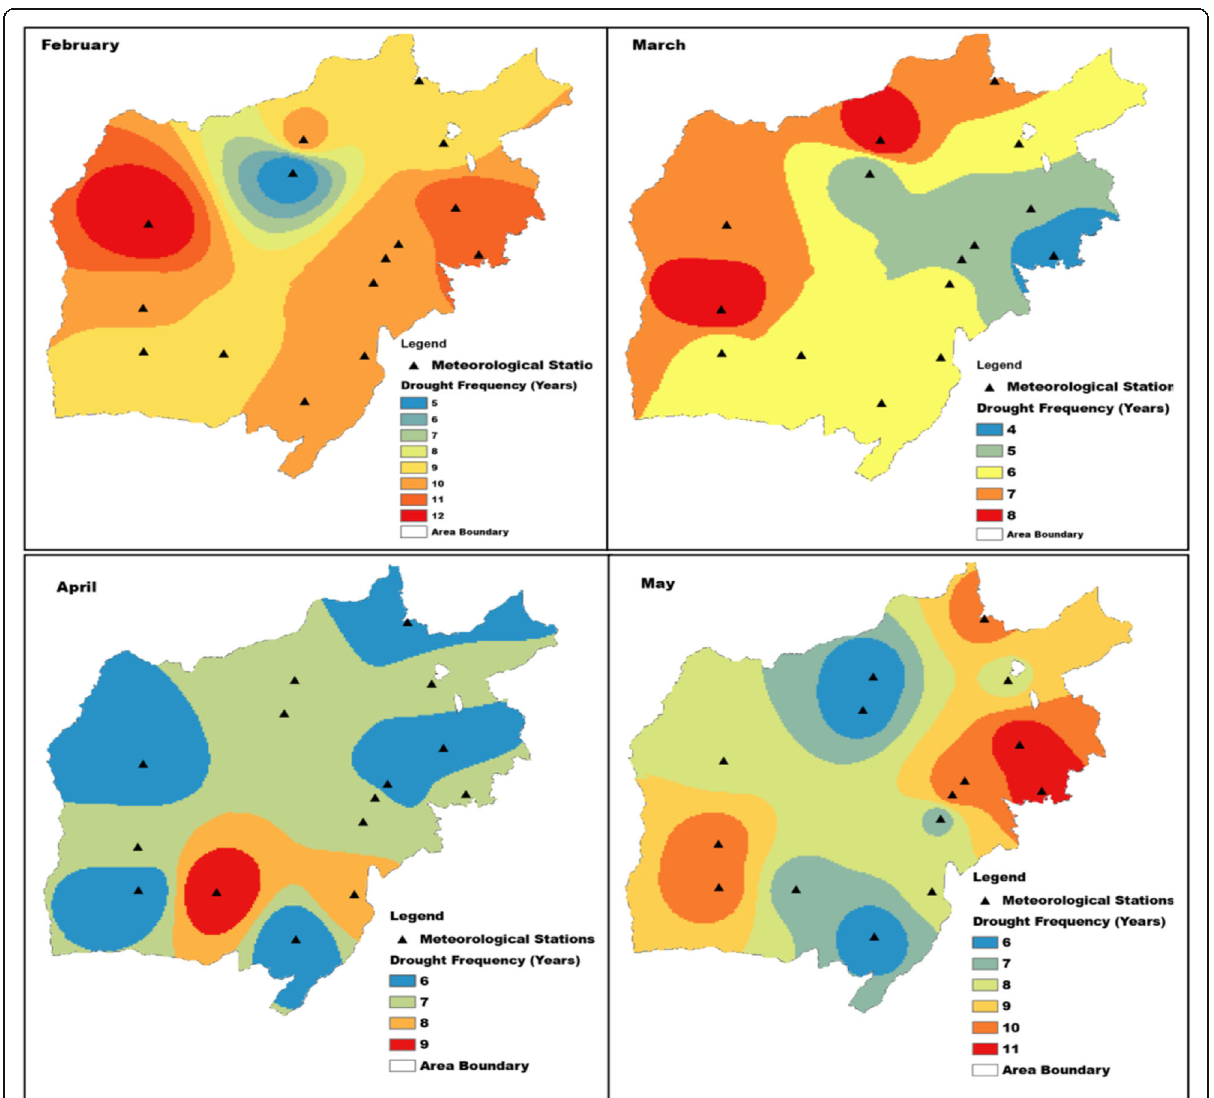
Fig. 5 The 1-month timesteps spatial pattern of drought frequency events (SPI ≤ − 1.0) for the small rainy months of February, March, April, and